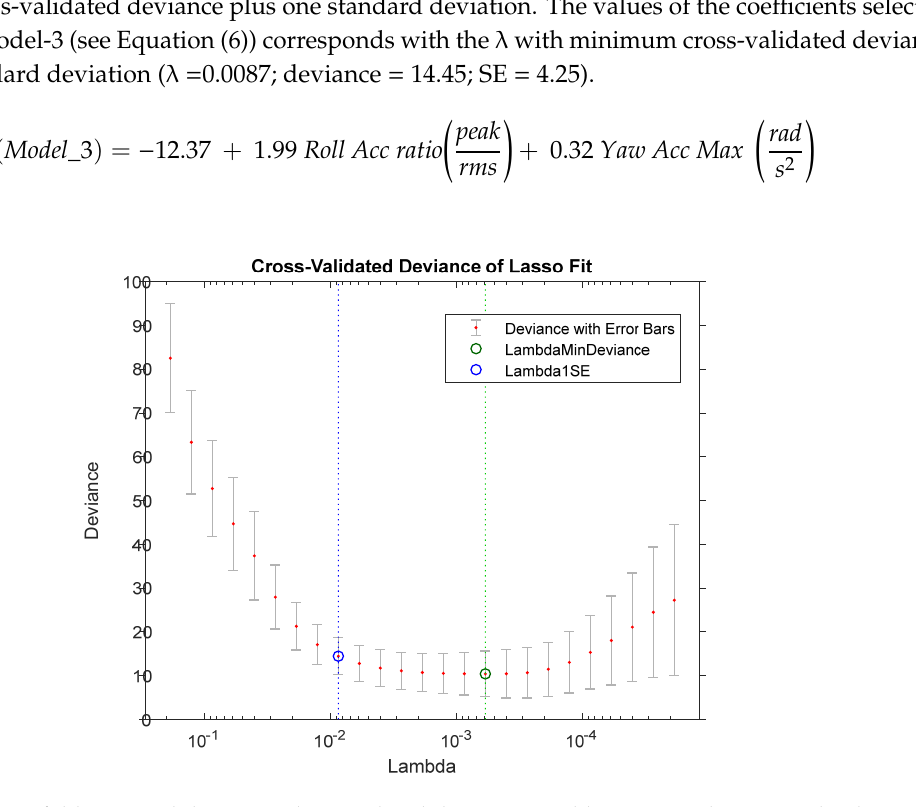
Figure 6. Ten-fold cross-validation on the simulated data sets. Red line: mean deviance; Blue line: bounds for deviances within one standard error. Table 2. Prediction Performance and best thresholds for the models.